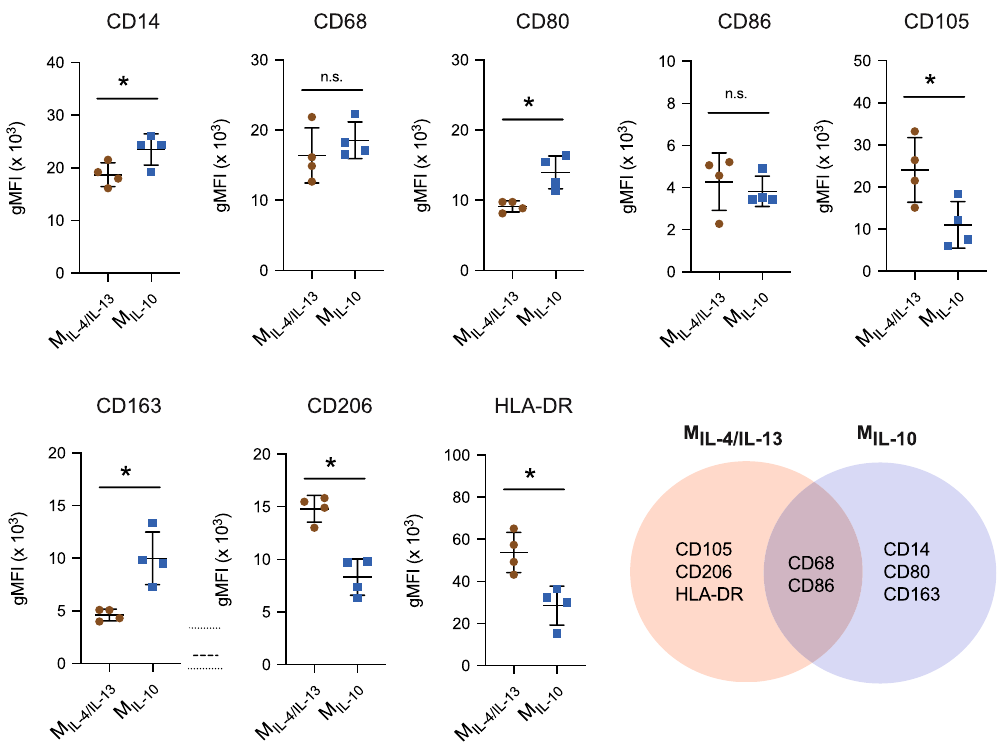
Fig. 2 Quantitative analysis of cell surface markers of M IL-4/IL-13 and M IL-10 . Cell surface markers were analyzed by immunocytostaining of CD14, CD68, CD80, CD86, CD105, CD163, CD206, and HLA-DR. Geometric mean fl uorescence intensity (gMFI) was plotted. Black line and error bar in the plot represent mean and standard deviation, respectively. * indicates a signi fi cance level of p ≤ 0.05 using Mann – Whitney test. Experiments were performed in four independent